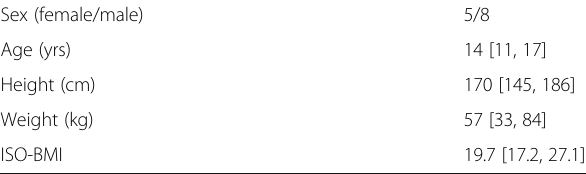
Table 1 Baseline characteristics. Data are median [minimum, maximum] or number of cases. ISO-BMI, International Obesity Task Force extension for body mass index to be used in children aged 2 – 18 years (Saari et al.